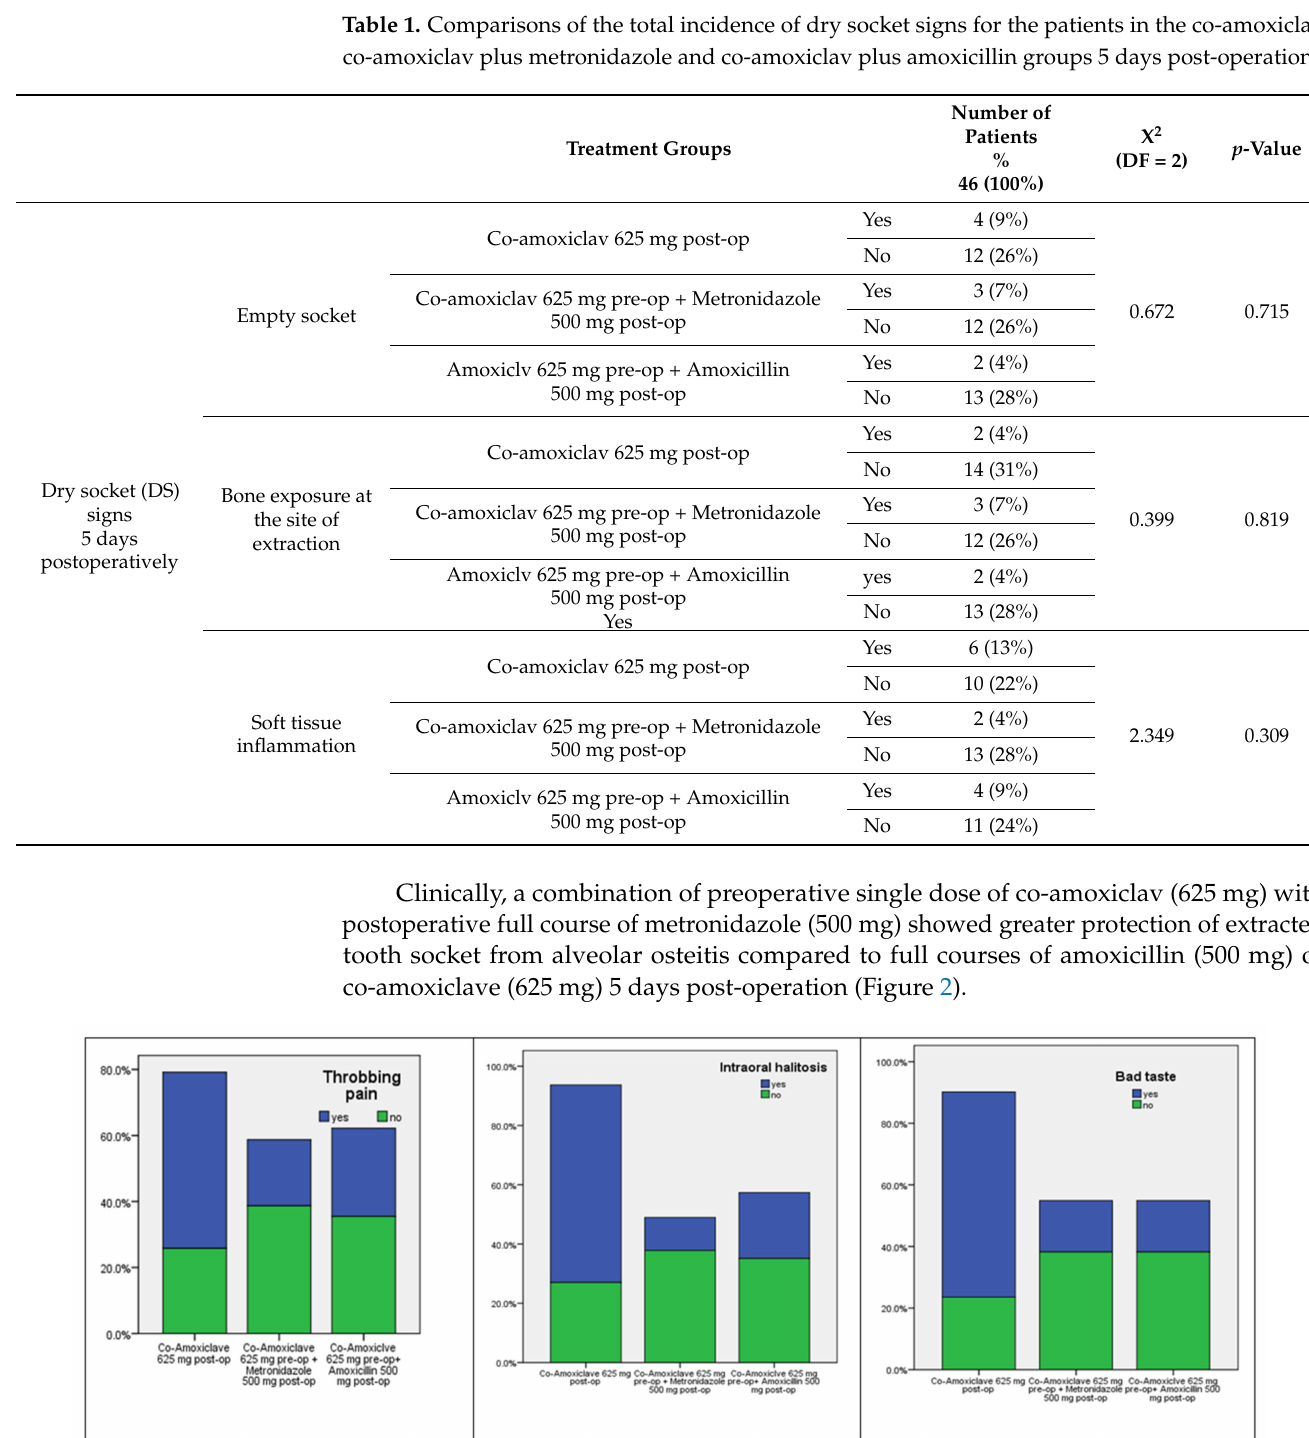
Number of Patients X 2 % (DF = 2) 46 (100%)